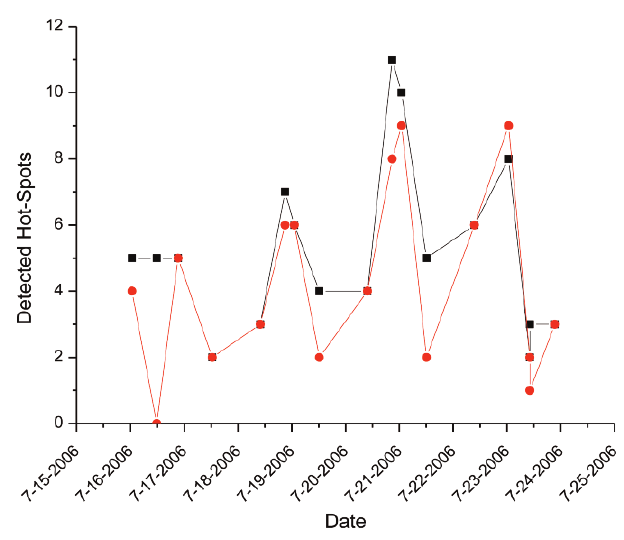
Figure 4. Hot-spots detected by RST (black) and by MODVOLC (red), VOLC for the Mount Etna eruption of July 15-24, 2006, from the processing of the MODIS data acquired with satellite zenith angles <40˚ (see main